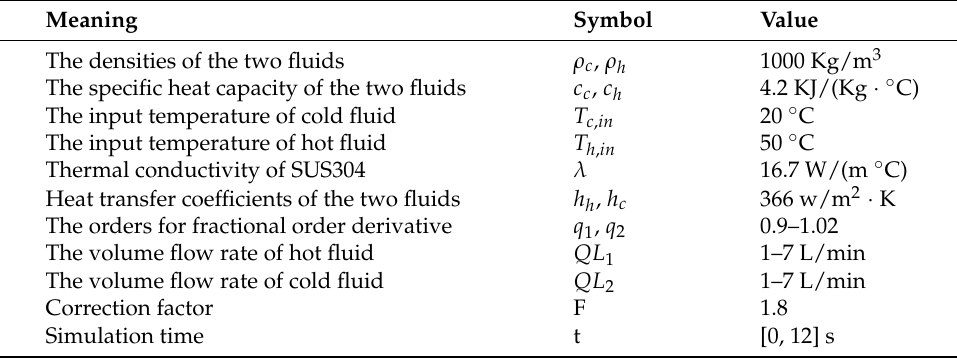
Table 3. Simulation parameters of the spiral-plate heat exchanger.